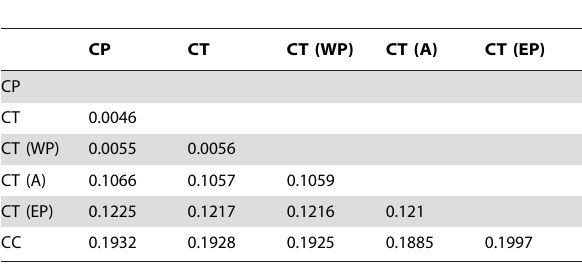
Table 1. Kimura-2-parameter distance among outgroup Chelonibia caretta , the five populations of C. testudinaria in Rawson et al. ( 2003) as well as C. testudinaria and C. patula examined in this study based on